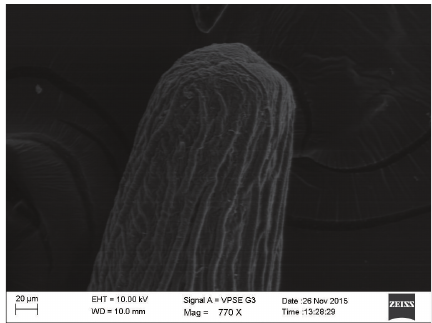
Figure 7: Cuticle of the worm (middle part) showing transverse striations and longitudinal ridges.